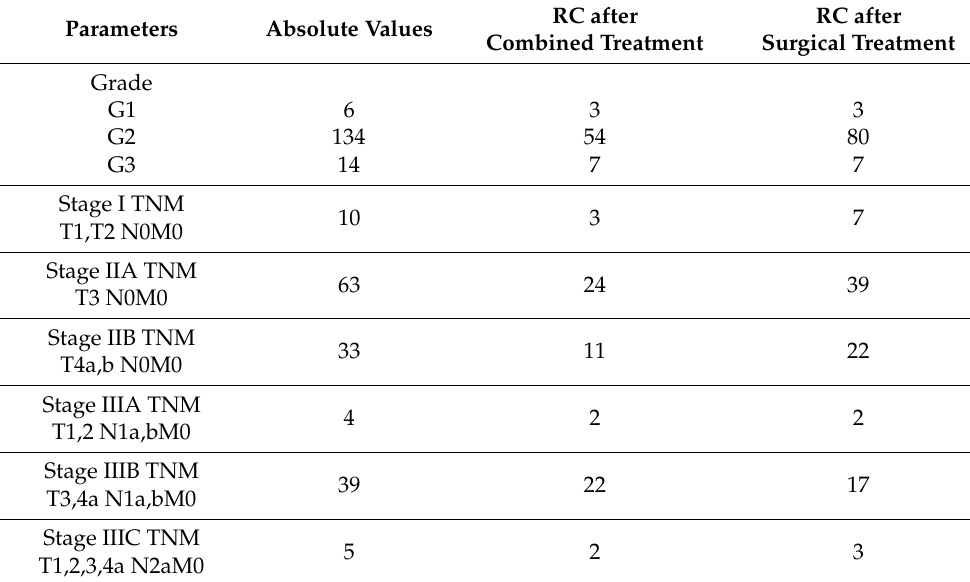
Table 1. Cont . Parameters Absolute